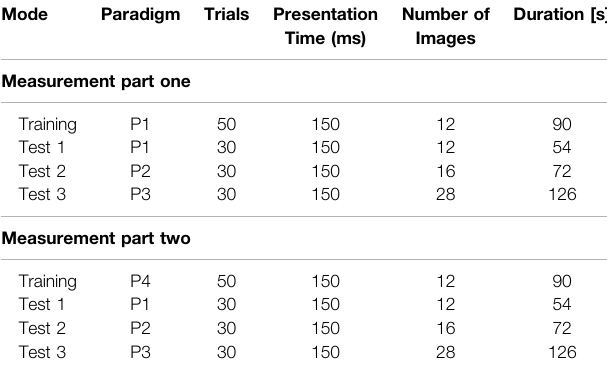
TABLE 2 | Measurement structure. In part one, the application was trained on the VEP produced by a female face and gray-scale images (P1). In part two, familiar facesandunfamiliarfaces(P4)wereused fortraining. P1,P2,and P3were used for testing. Each image was displayed 150 ms, with the next immediately following the previous. The training paradigm was presented 50 times, and each test paradigm 30